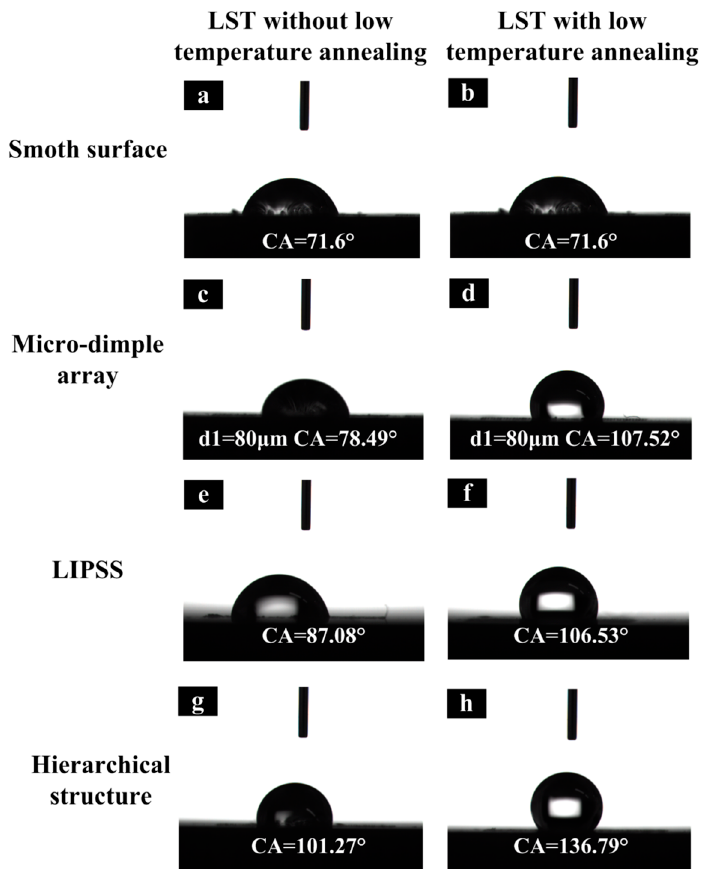
Figure 10. The contact state and contact angles of the textured surface: ( a ) untreated surface; ( c ) micro-dimple-array with a pitch distance of 80 μ m and a diameter of 40 μ m; ( e ) LIPSS texture; ( g ) the hierarchical texture; ( b , d , f , h ) represent the corresponding surface by low-temperature annealing treatment, respectively.